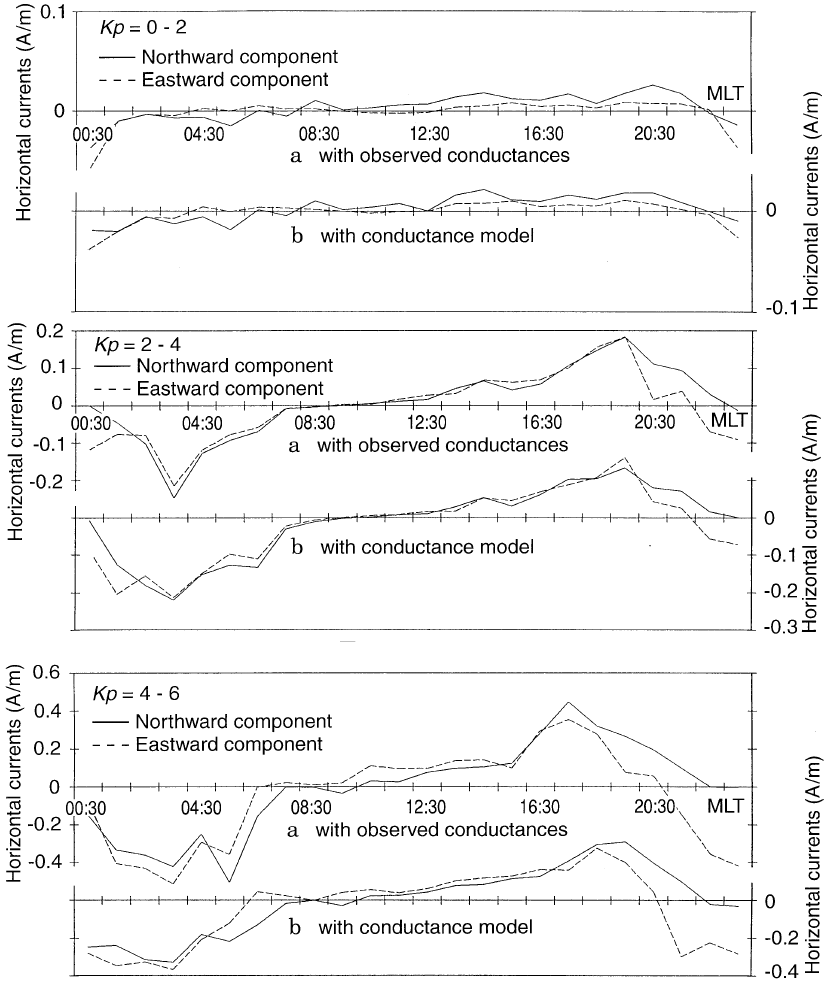
Fig. 1. MLT variations at 67 ° invariant latitude of the northward J (cid:78) ( full line ) and eastward J (cid:69) ( dashed line ) components of the statistical height-integrated horizontal currents derived with conductances observed by EISCAT (a) or with conductance models (b) (see text). The three panels correspond to the three magnetic-activity ranges: Kp " 0 — 2, 2 — 4, and 4 —